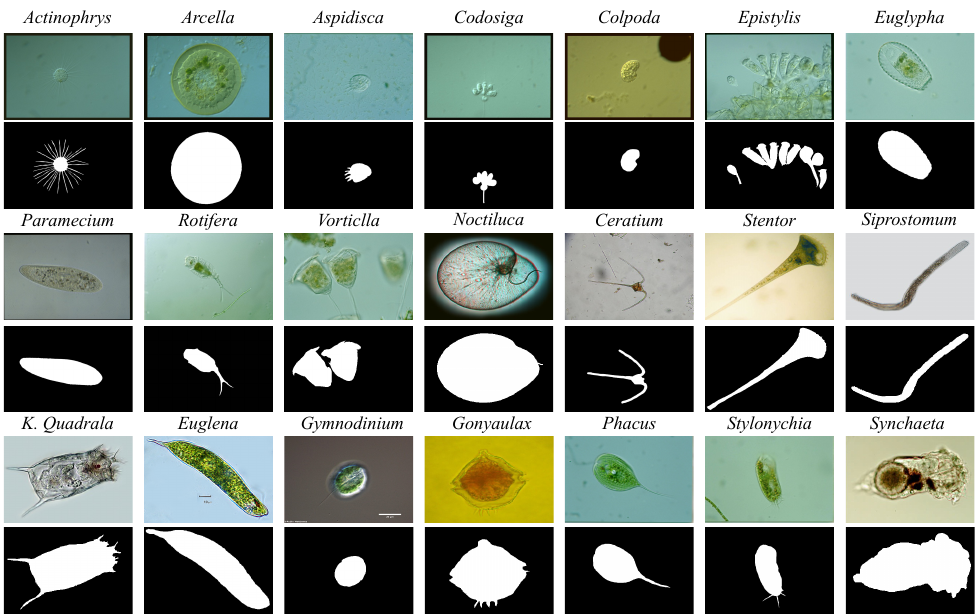
Figure 11. The EMs images in EMDS-6. The color images above are original images and the binary images below are the corresponding GT